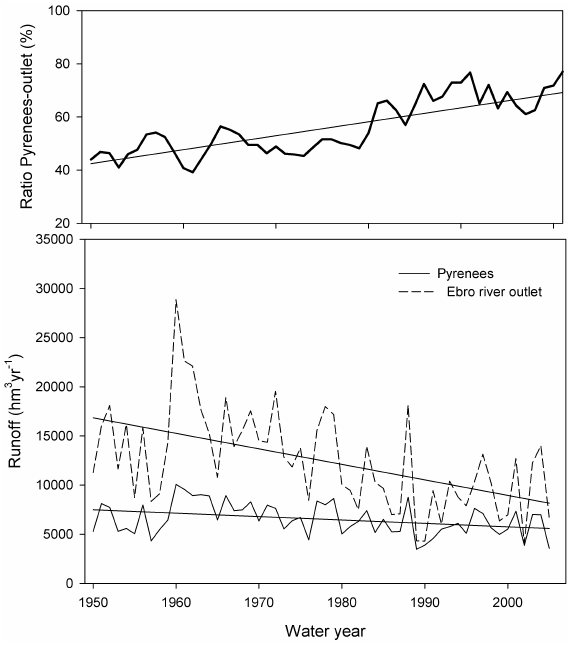
Fig. 7. Annual runoff from Pyrenean headwaters and the discharge of the Ebro River in its lower reaches (lower panel). Evolution of the ratio between the series (upper